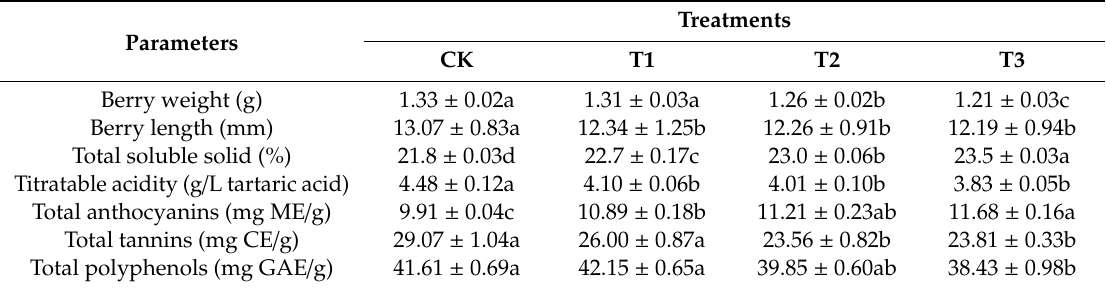
Table 1. General composition of Cabernet Sauvignon grapes in the control berries and sequential harvest